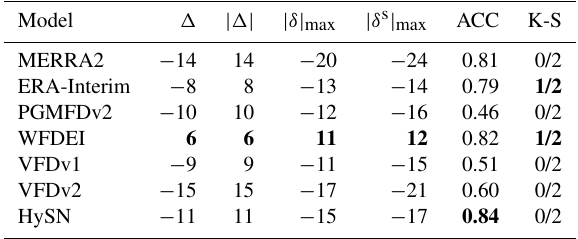
Table 5. As in Table 3 but with metrics listed for LW ↓ . Except for ACC and KS, which are dimensionless, the units are in Wm − 2 .